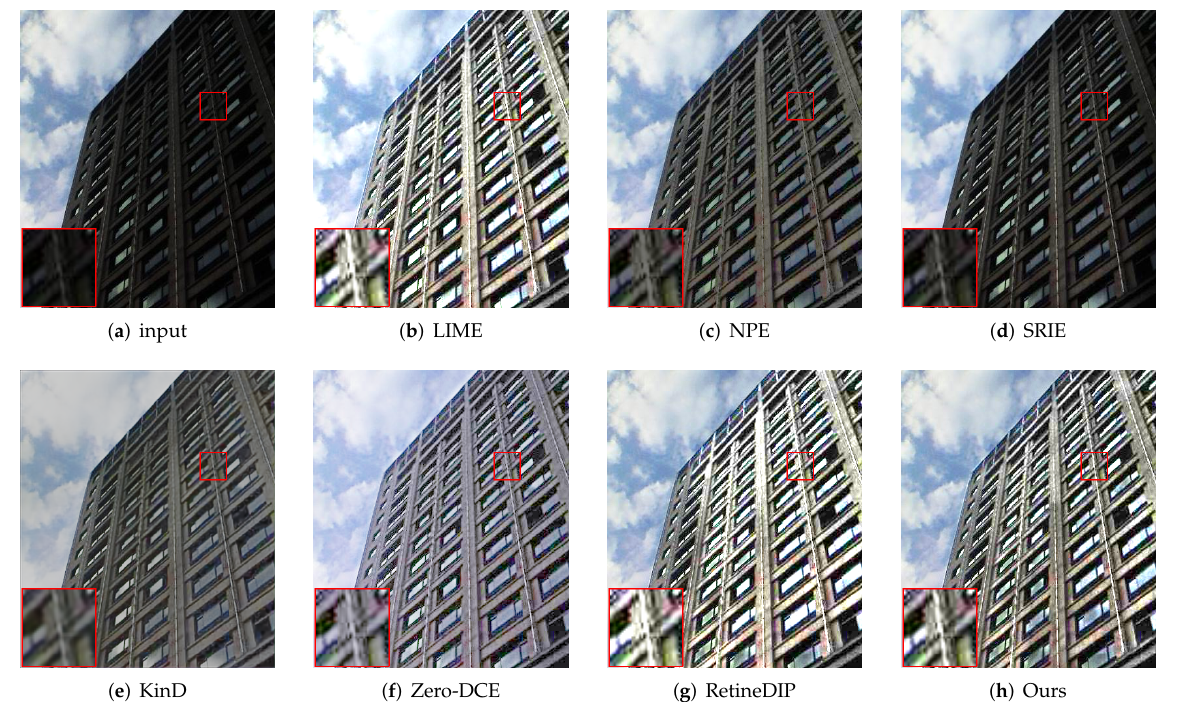
Figure 3. Comparisons of enhanced images. Red boxes indicate the obvious differences. Compared with other methods, our method yields natural exposure and clear details.